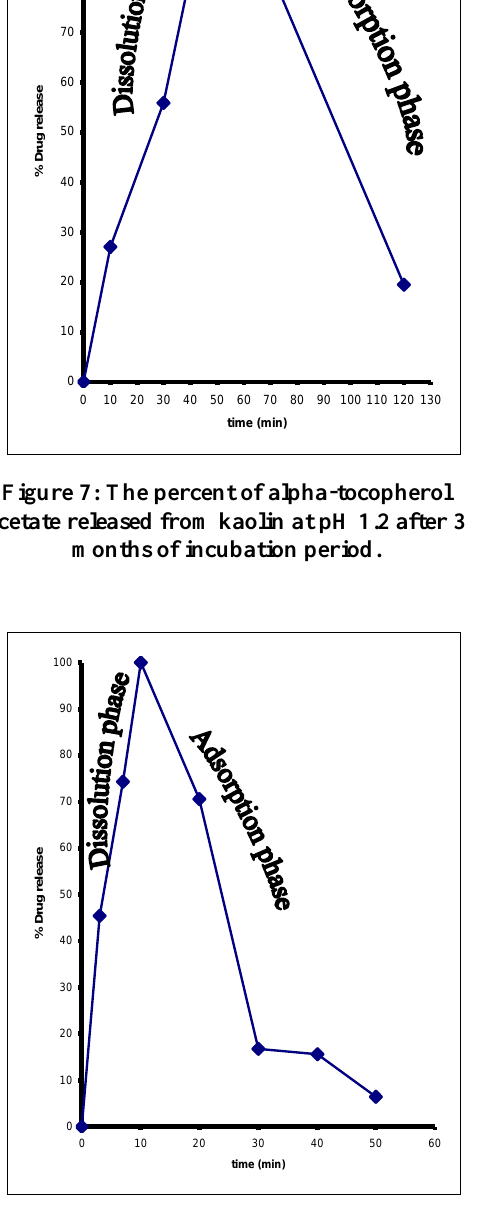
Figure 8: The percent of alpha-tocopherol acetate released from magnesium carbonate at pH 1.2 after 3 months of incubation period.